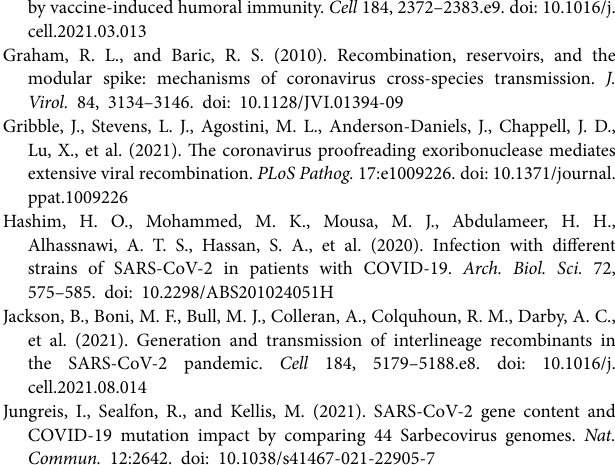
Supplementary Table S2 | Amino acid mutations of S protein in each group and the effect. Supplementary Table S3 | Sequences involving genetic